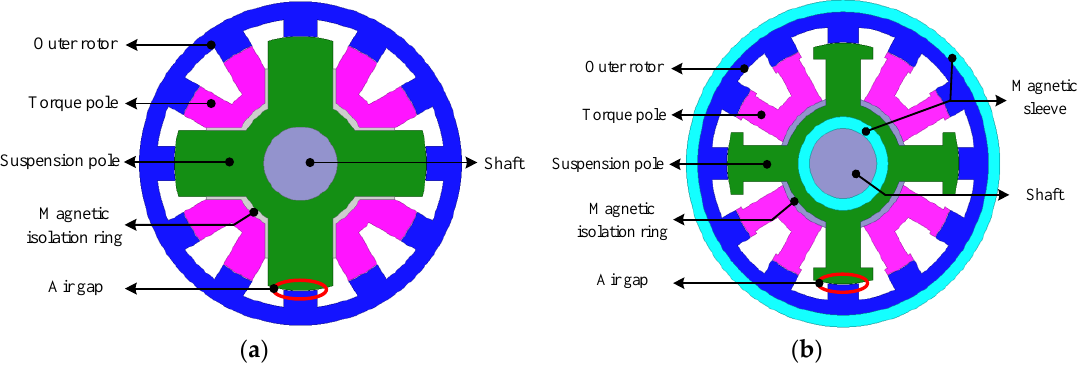
Figure 11. Cross section of machine before and after optimization: ( a ) before optimization; ( b ) after optimization.